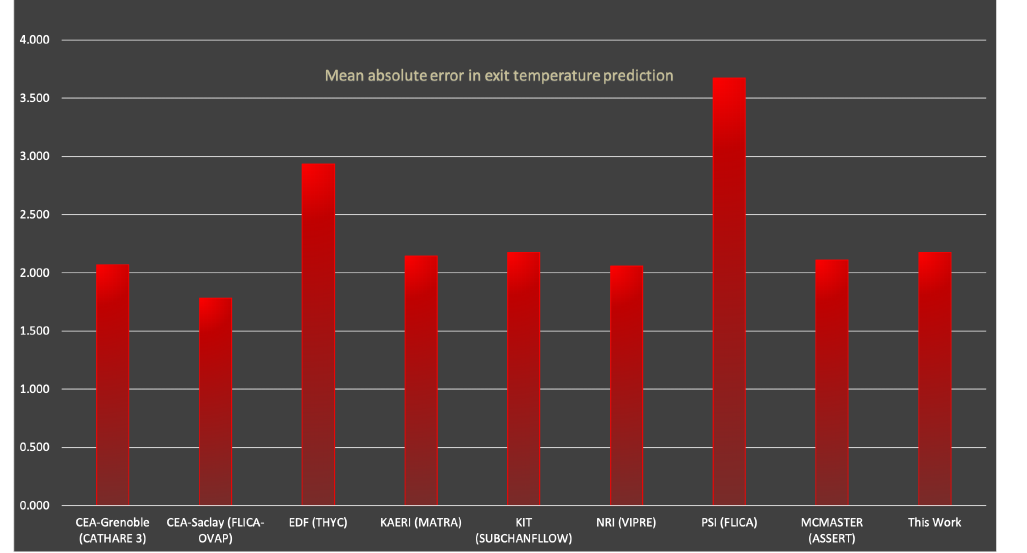
Figure 11. Mean absolute error in predicted exit